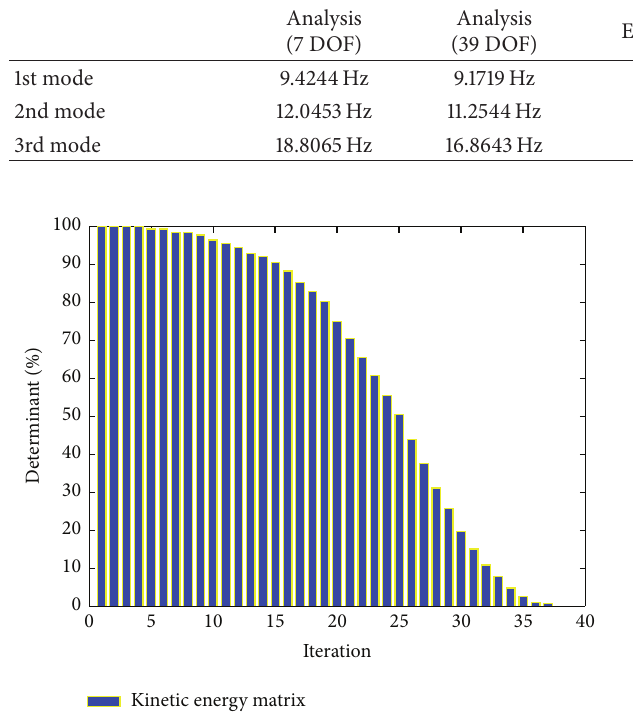
Figure 7: Kinetic energy matrix values to DOF